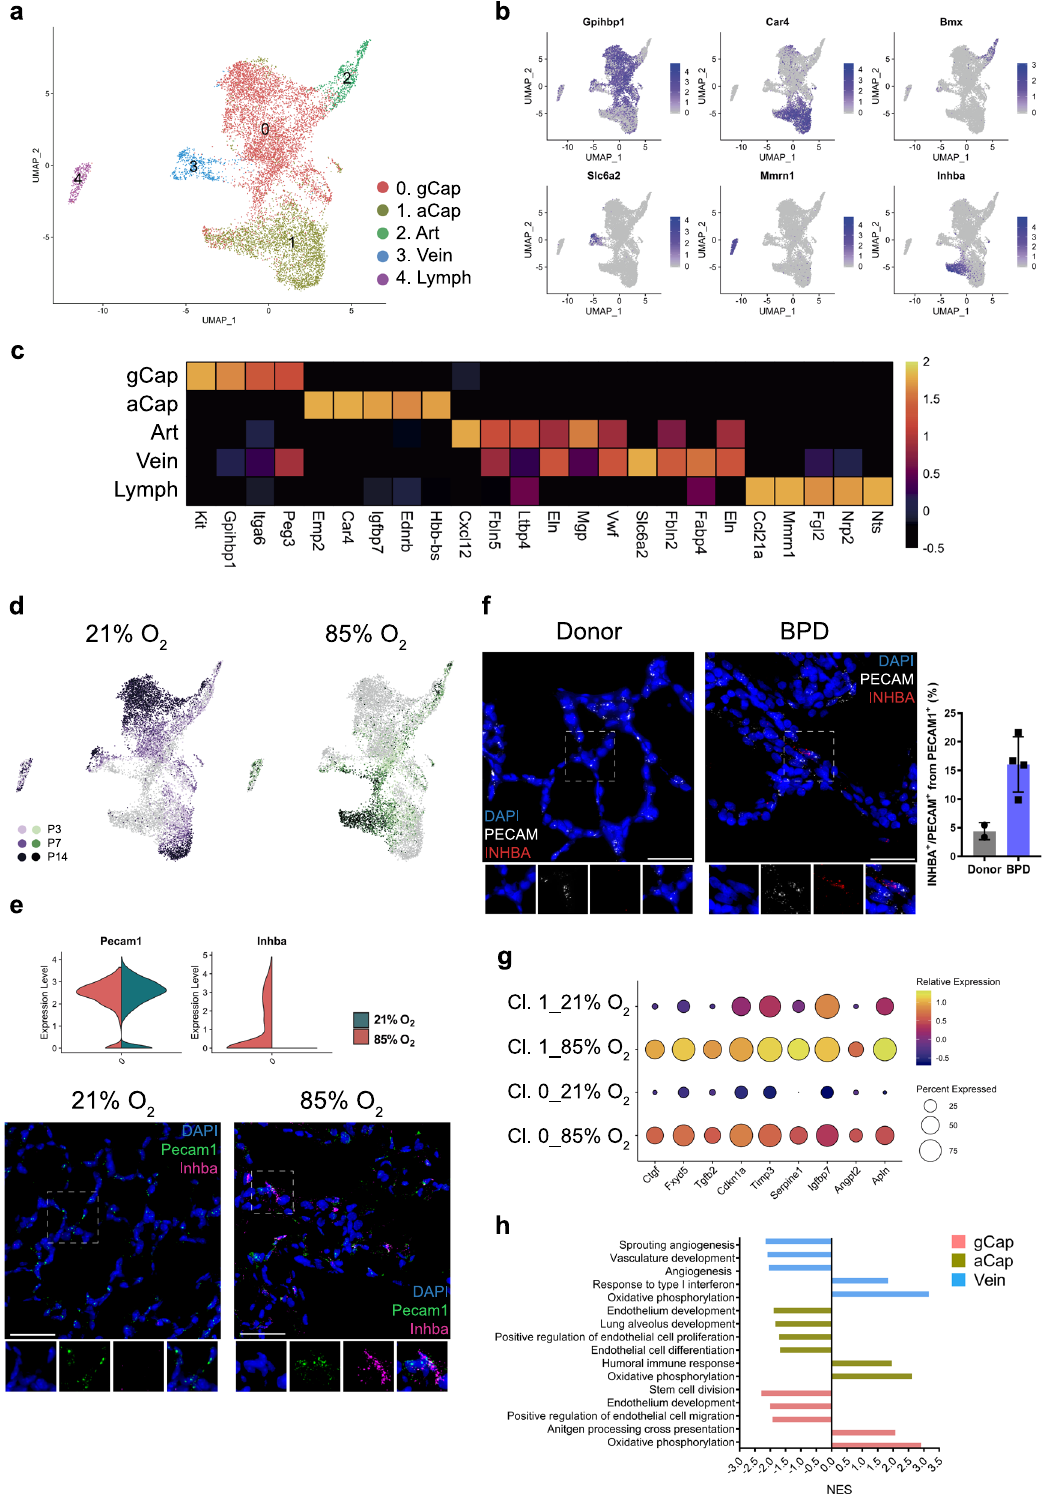
cluster (Supplementary Fig. 7g). This is in concordance with recent fi ndings in adult lungs showing that the regenerative potential of endothelial cells was not restricted to a particular subset of cells 48 .